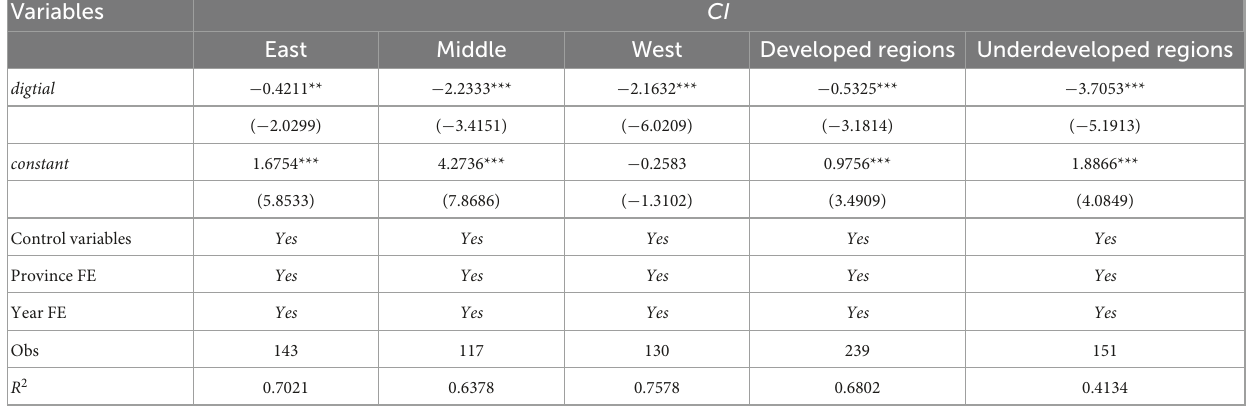
TABLE 8 Heterogeneity analysis results.